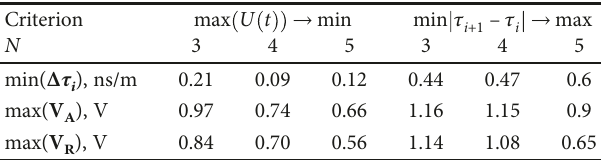
Table 3: Results of MF optimization for N = 3, 4, 5 separately by two